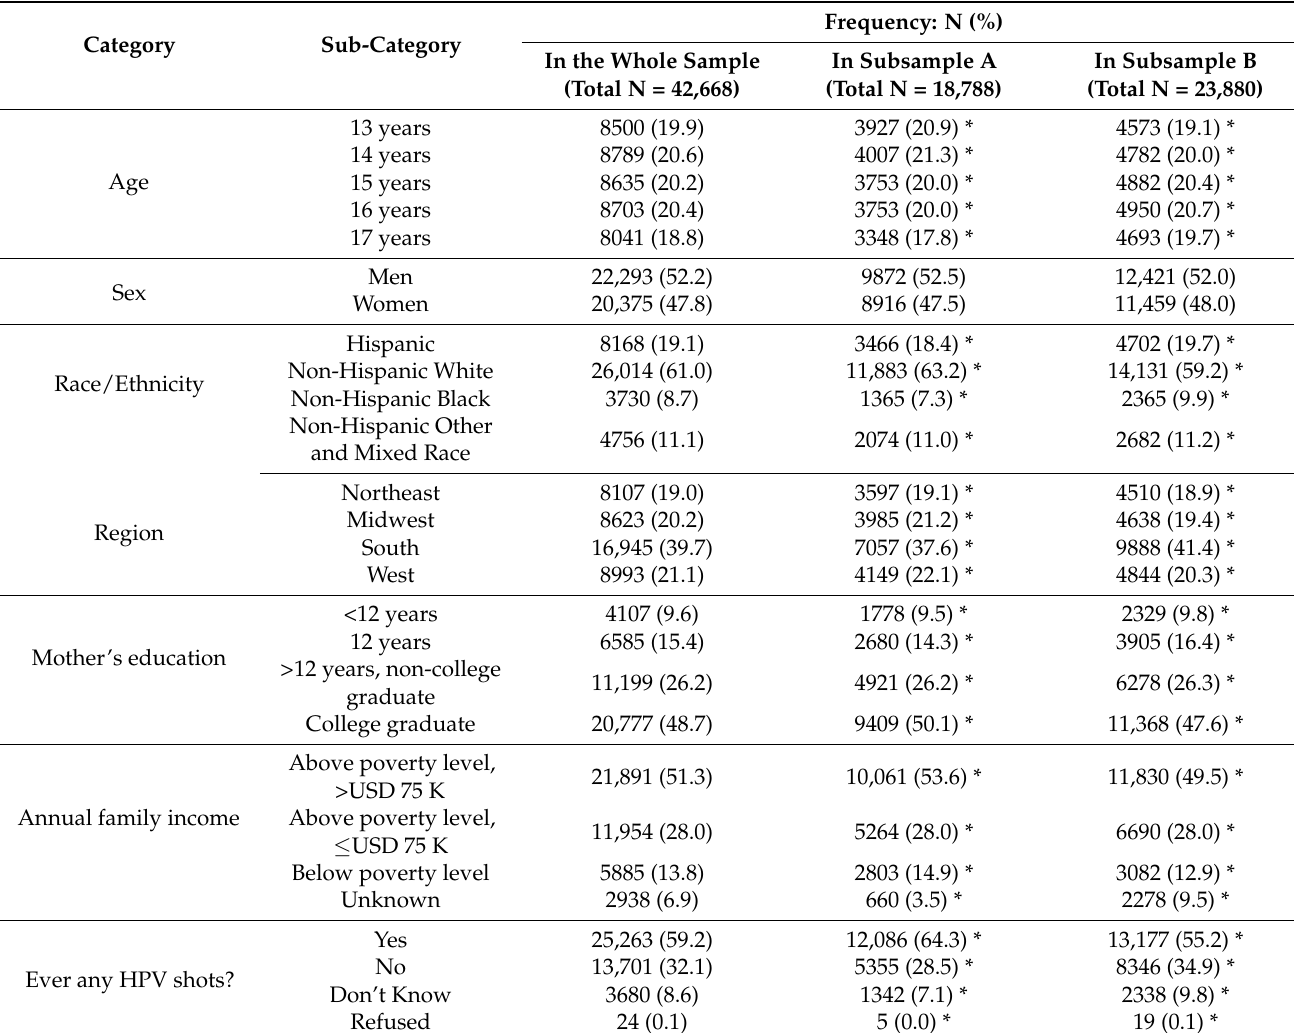
Table 1. Sociodemographic characteristics of the teens in the current study from the 2019 National Immunization Survey